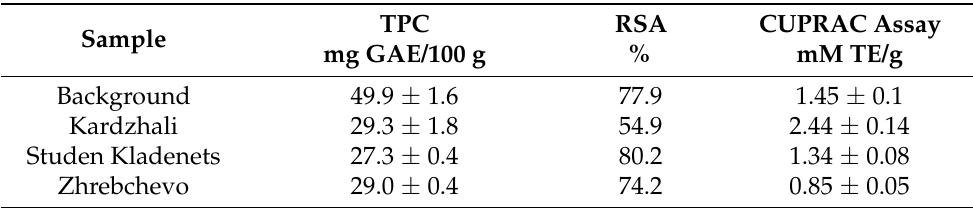
Table 1. Antioxidant activity and polyphenolic compounds in Fontinalis antipyretica . Legend: TPC—